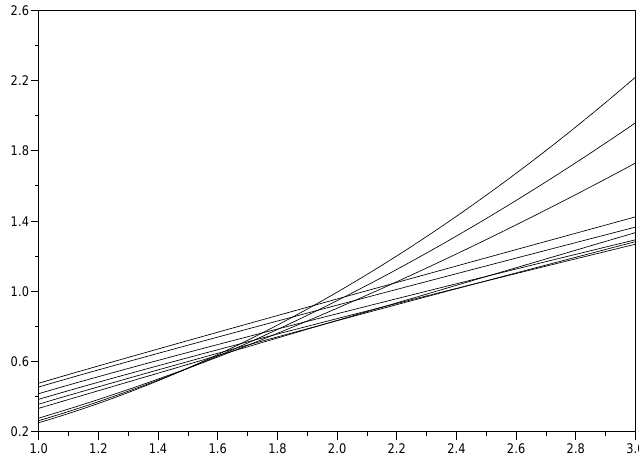
(cid:82) t B H ( s ) ds , given by (20), as a function of t > u , 0